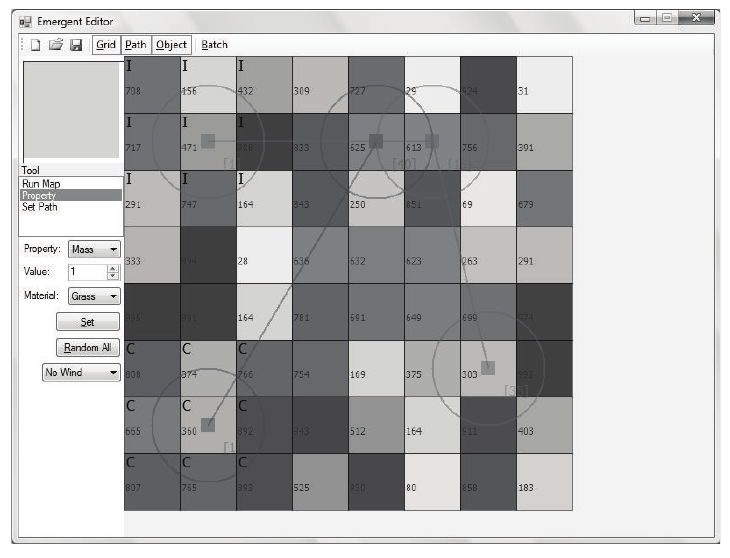
Figure 7: Property editor.